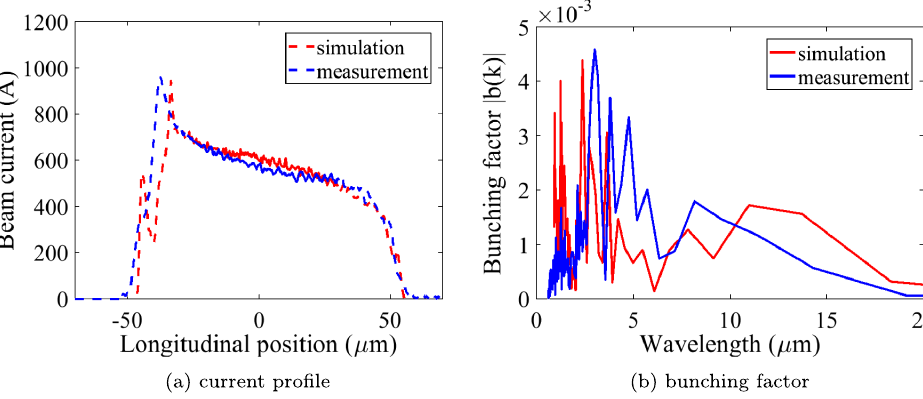
FIG. 12. The final current profile (left) and bunching factor (right) of the Fig. 11 longitudinal phase-space distribution with the laser heater at 19